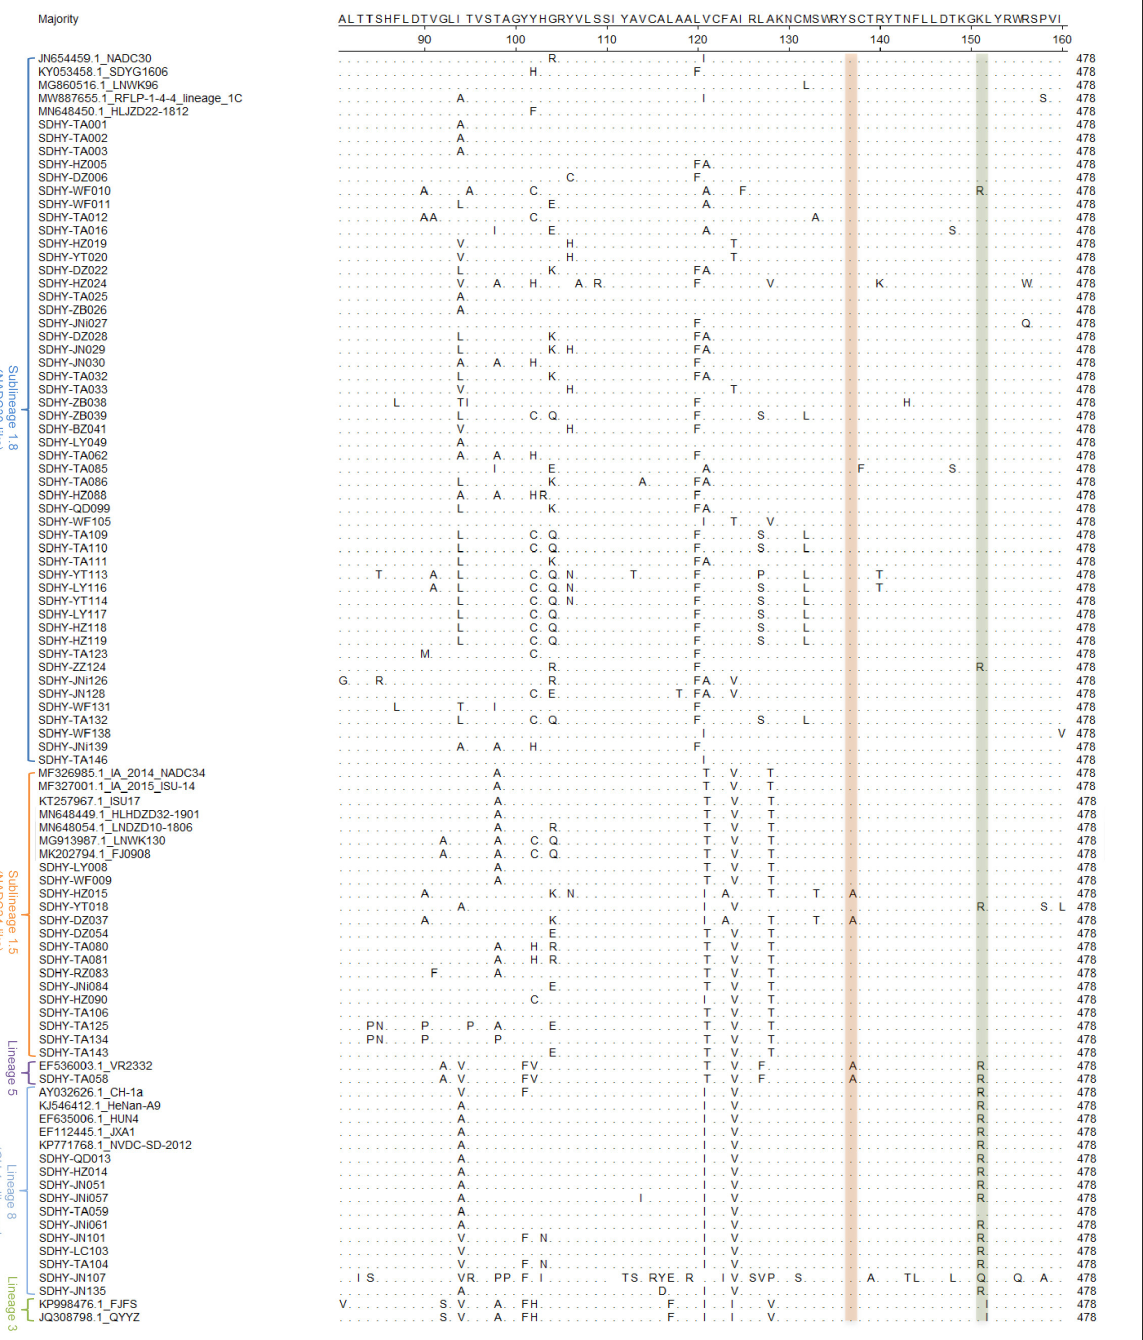
FIGURE4 Analysis based on the major amino acid mutation sites of the PRRSV ORF5